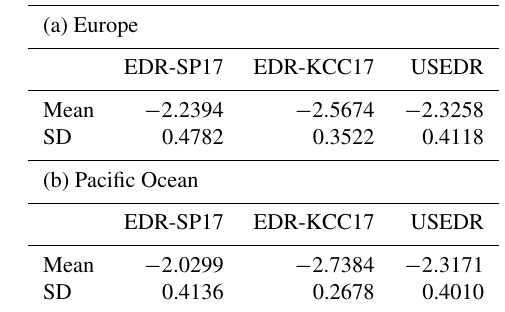
Table 2. Values of the mean and SD of the natural logarithms of EDR-SP17, EDR-KCC17, and USEDR over (a) Europe and (b) the Pacific Ocean routes indicated in Fig. 10, from October 2015 to September 2018. The unit is m 2 / 3 s − 1